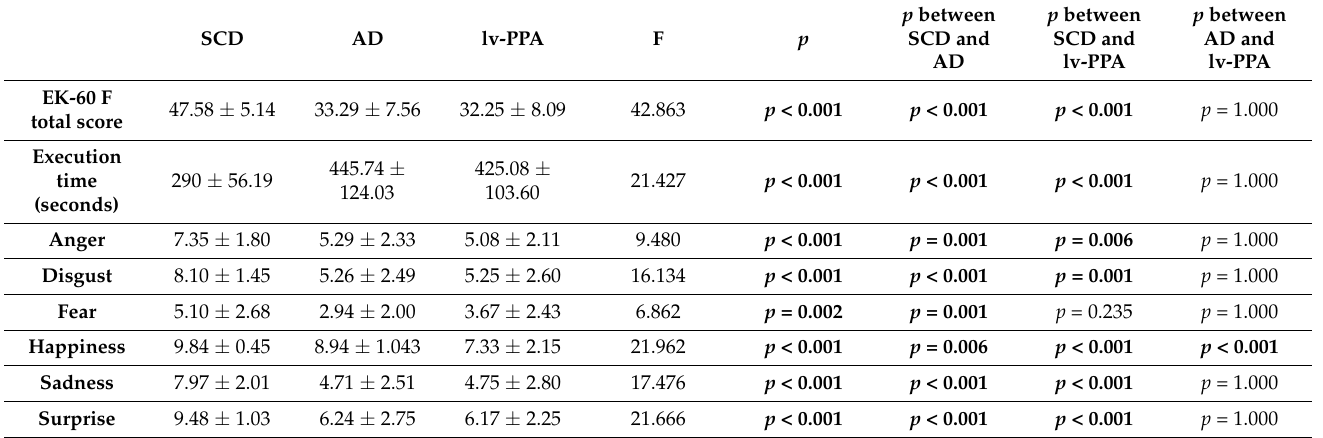
Table 3. Facial emotion recognition ability in subjective cognitive decline (SCD), Alzheimer’s disease (AD), and logopenic variant primary progressive aphasia (lv-PPA) as assessed by the Ekman 60 Faces Test (EK-60